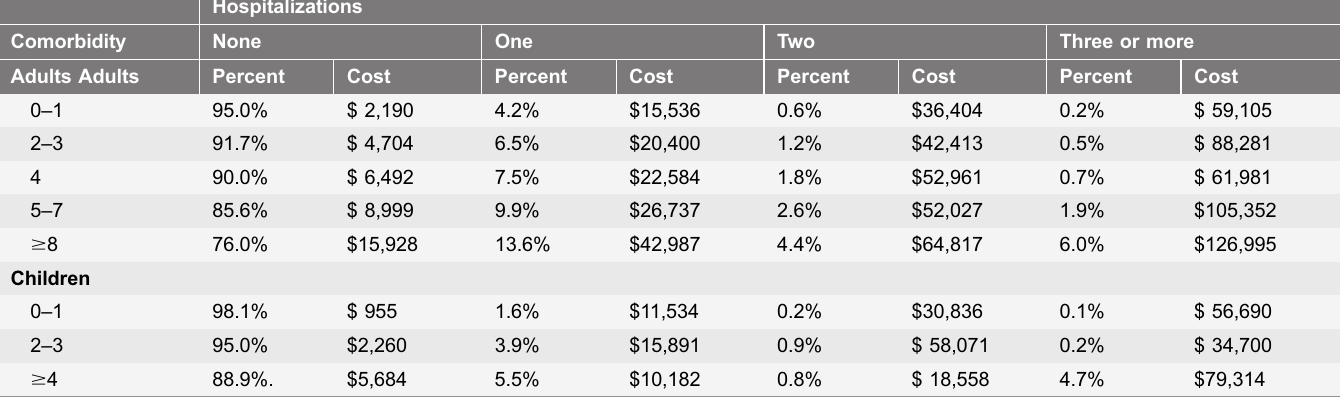
The numbers of patients in each comorbidity group are shown on Table 1. Costs adjusted for age, gender, major mental health diagnoses, and zip code of